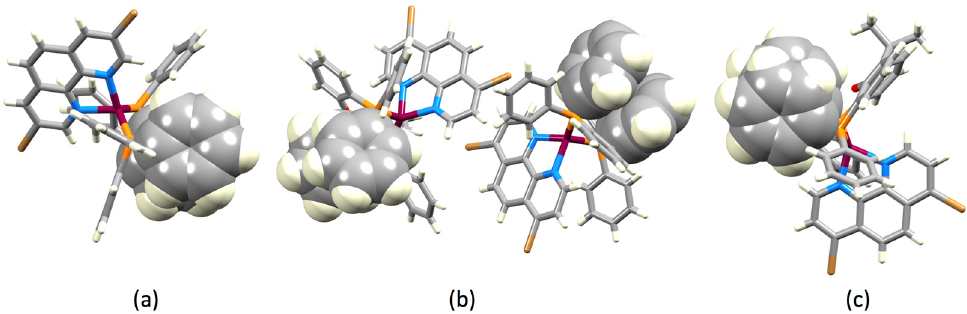
Figure 5. Space-filling representations of the π -stacking between one phenyl ring of a PPh 2 unit and one arene ring of the POP backbone in ( a ) [Cu(POP)(3,8-Br 2 phen)] + and ( b ) the independent [Cu(POP)(4,7-Br 2 phen)] + cations. ( c ) Space-filling representation of the π -stacking between two phenyl rings of di ff erent PPh 2 units in [Cu(xantphos)(4,7-Br 2 phen)] + .